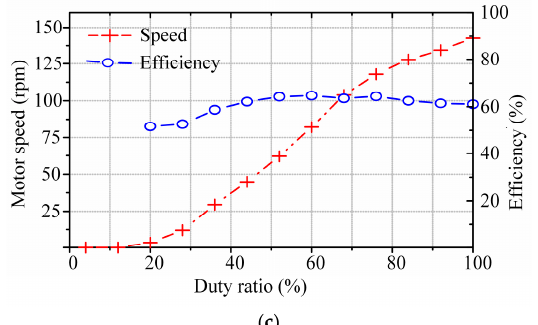
Figure 12. Measured speed regulation characteristics using burst fire control: ( a ) motor 1; ( b ) motor 2; and ( c ) motor 3.